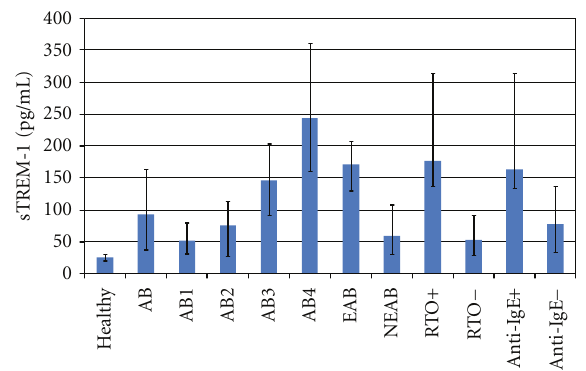
Figure 1: Plasma levels of sTREM-1 in healthy subjects and asthma bronchiale patients AB: asthma bronchiale, AB1: mild intermittent AB, AB2: mild persistent AB, AB3: moderate persistent AB,